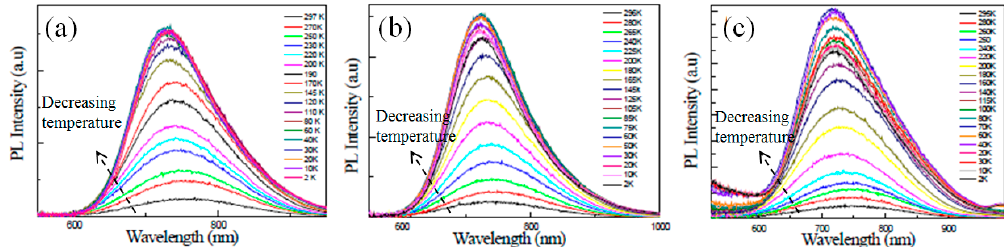
Figure 2. Spectra of ( a ) ncSi-H:O (0.6) ( b ) ncSi-H:O (0.55), and ( c ) ncSi-H:O (0.4), with decreasing temperature from 300K to 4K. Temperature of the corresponding emission is shown in the legends.